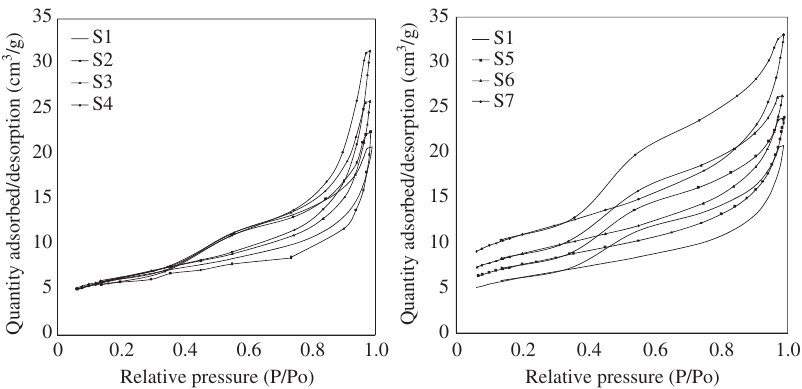
Figure 6 BET isotherm of artifically mixed soil and silt